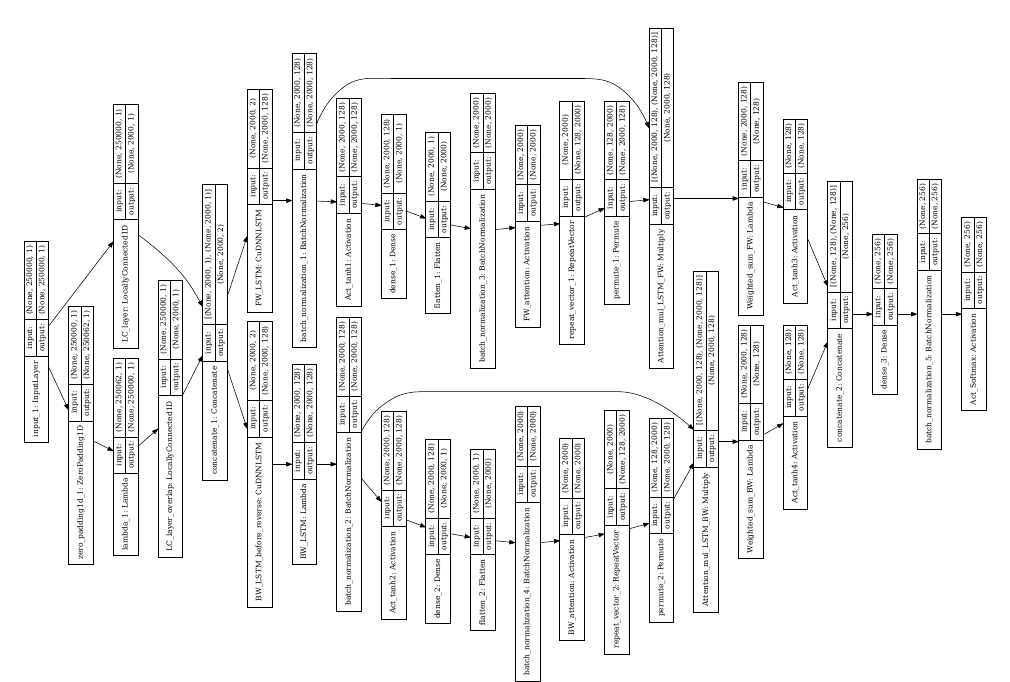
Figure 24: Network for synchronized ASCAD v1.